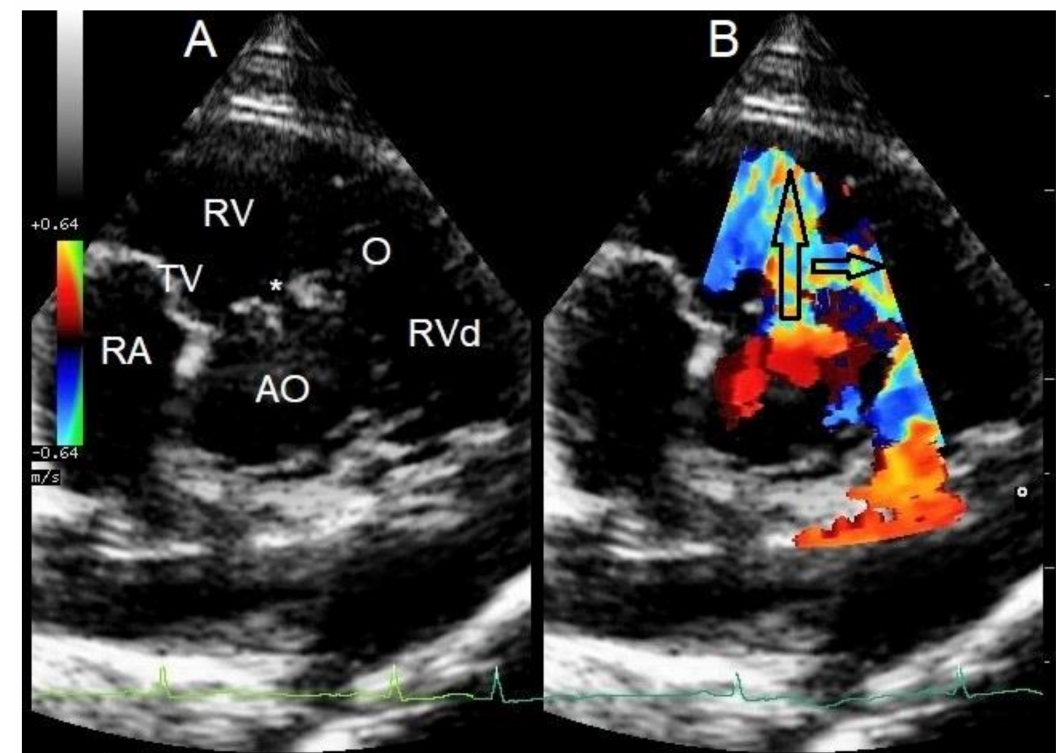
Figure 1. Cross-sectional echocardiographic images at the level of the heart base from the standard right parasternal short axis view performed at 10 weeks of age. ( A ) Two-dimensional image shows a small ventricular septal defect (*) close to the aortic (AO) and tricuspid valves (TV) and a localized muscular band in the right ventricle (O) just distal to the ventricular septal defect. RA—right atrium, RV—right ventricular chamber proximal to the obstruction, RVd—right ventricular chamber distal to the obstruction ( B ) Color Doppler image of the same view as in Figure 1A shows two high-velocity jets in the right ventricular chamber. The jet indicated by the large, vertically positioned arrow is caused by the left-to-right shunting ventricular septal defect, and the jet indicated by the smaller, horizontally positioned arrow is caused by the right ventricular intraluminal obstruction (O). The arrows also indicate the origin and direction of abnormal blood